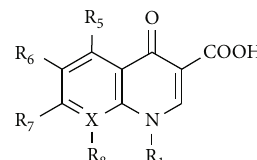
Figure 2: The general structure of quinolone.